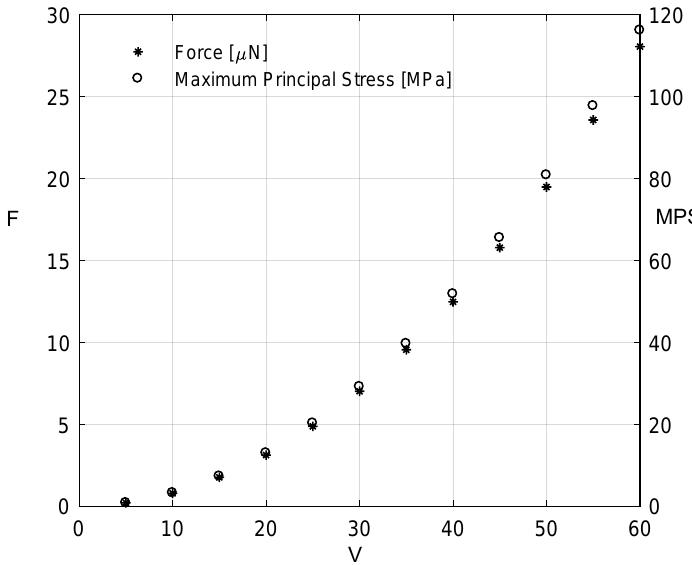
Figure 7. One-link microgripper: force magnitudes exerted by each comb drive and maximum values of the Maximum Principal Stress (MPS) as a function of the applied electric potential difference.